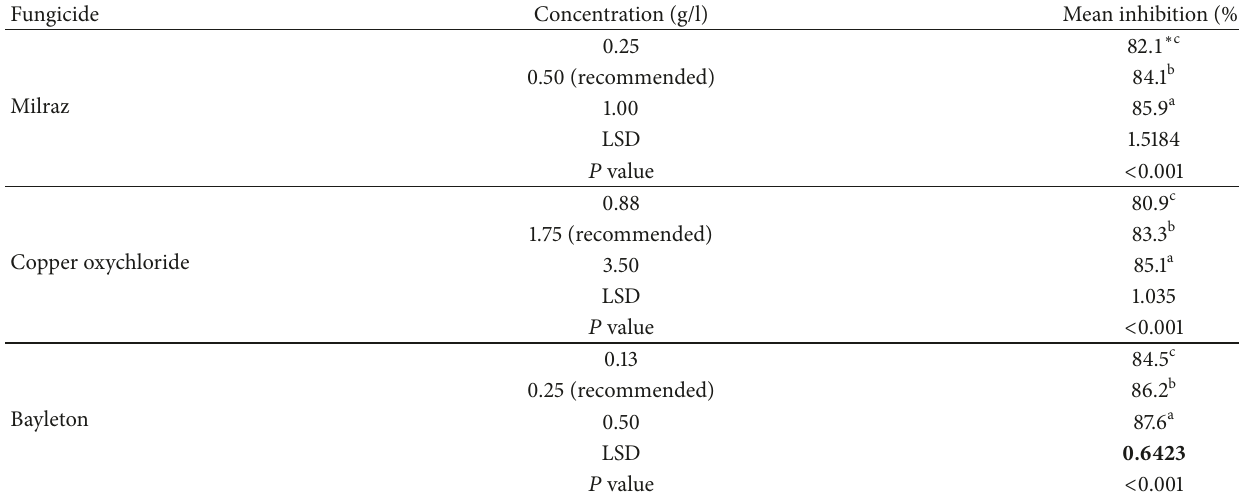
Table 2: Effect of selected fungicides on mycelial growth of Colletotrichum gloeosporioides